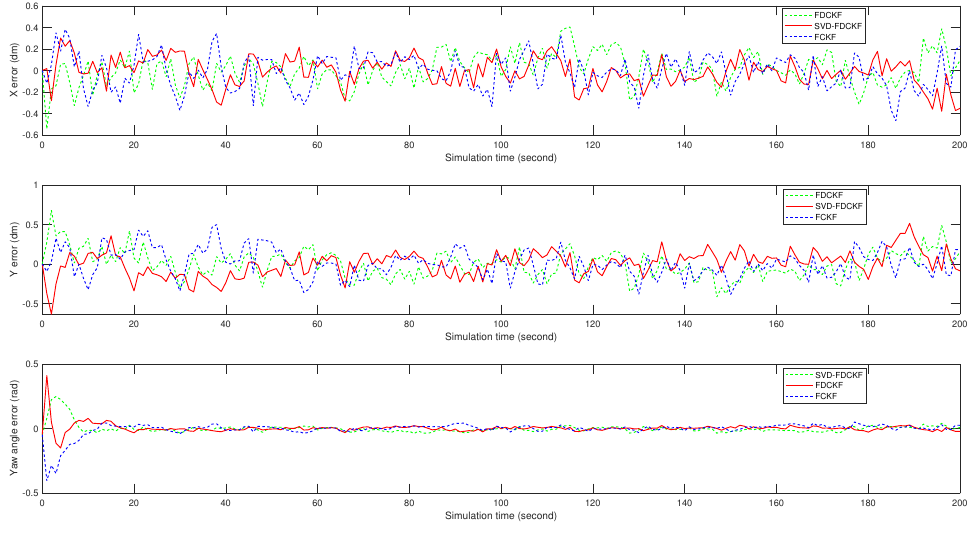
Figure 6. The attitude errors of mobile robots, including x coordinate, y coordinate, and yaw angle θ , are estimated by FCKF, FDCKF, and SVD-FDCKF algorithms at 200 path points, respectively.